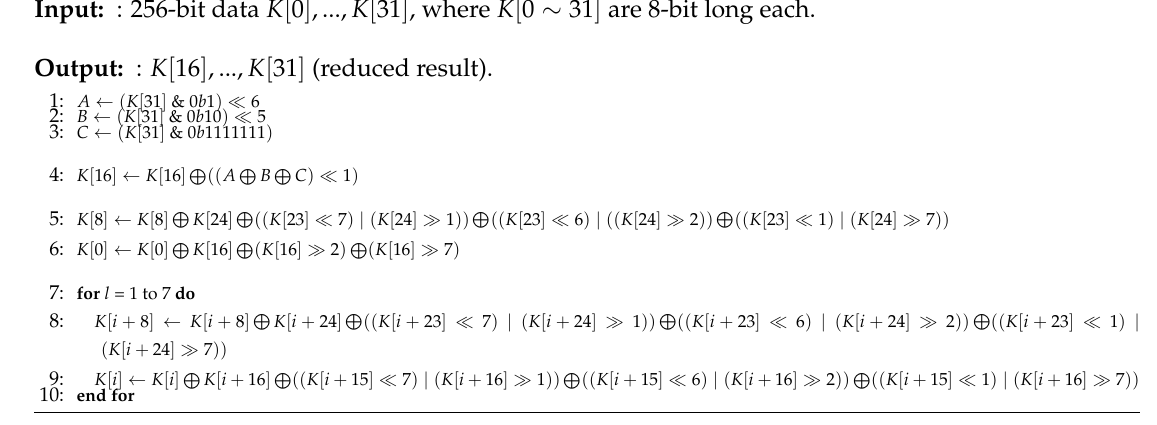
Algorithm 3 Proposed method for fast modular